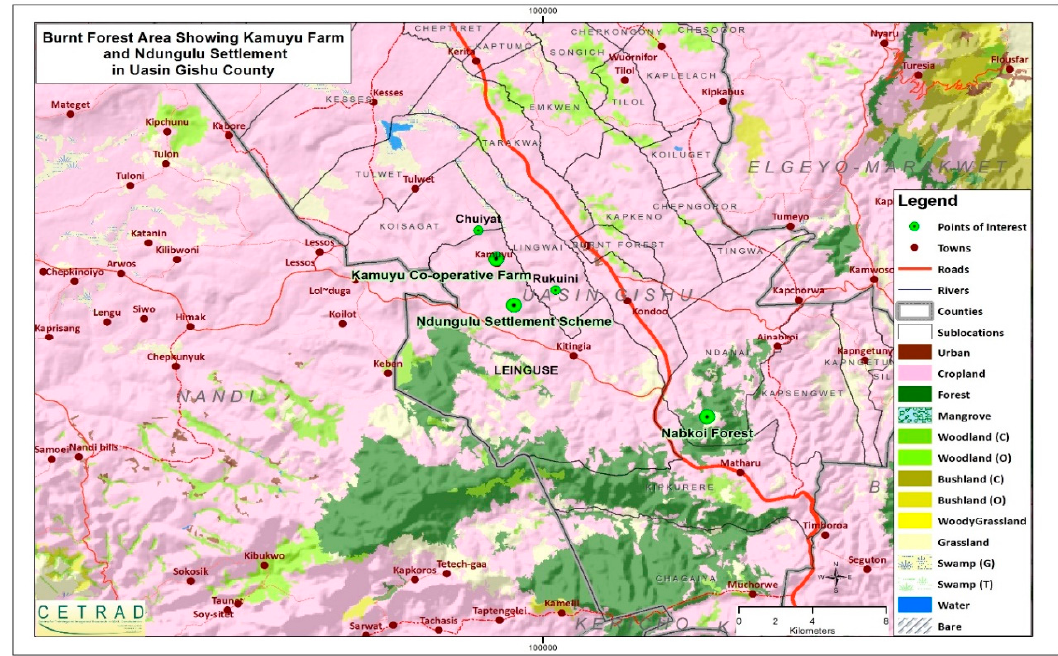
Figure 2. Map of the Burnt Forest Area showing Kamuyu farm and Ndungulu settlement.